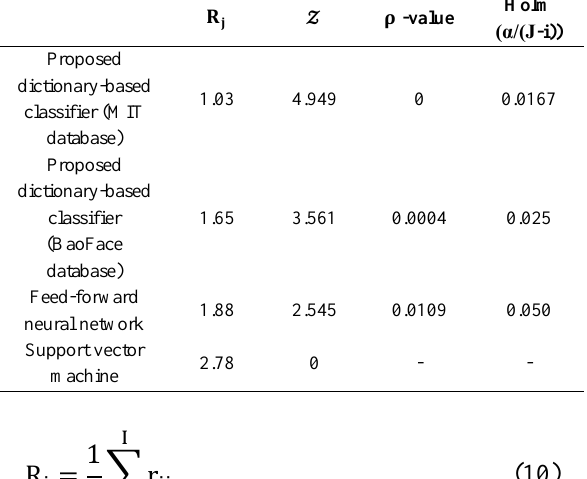
Table 12. The results of statistical test to compare the performance of the neural network, support vector machine, and dictionary-based classifier in order to detect face regions of an input image based on different